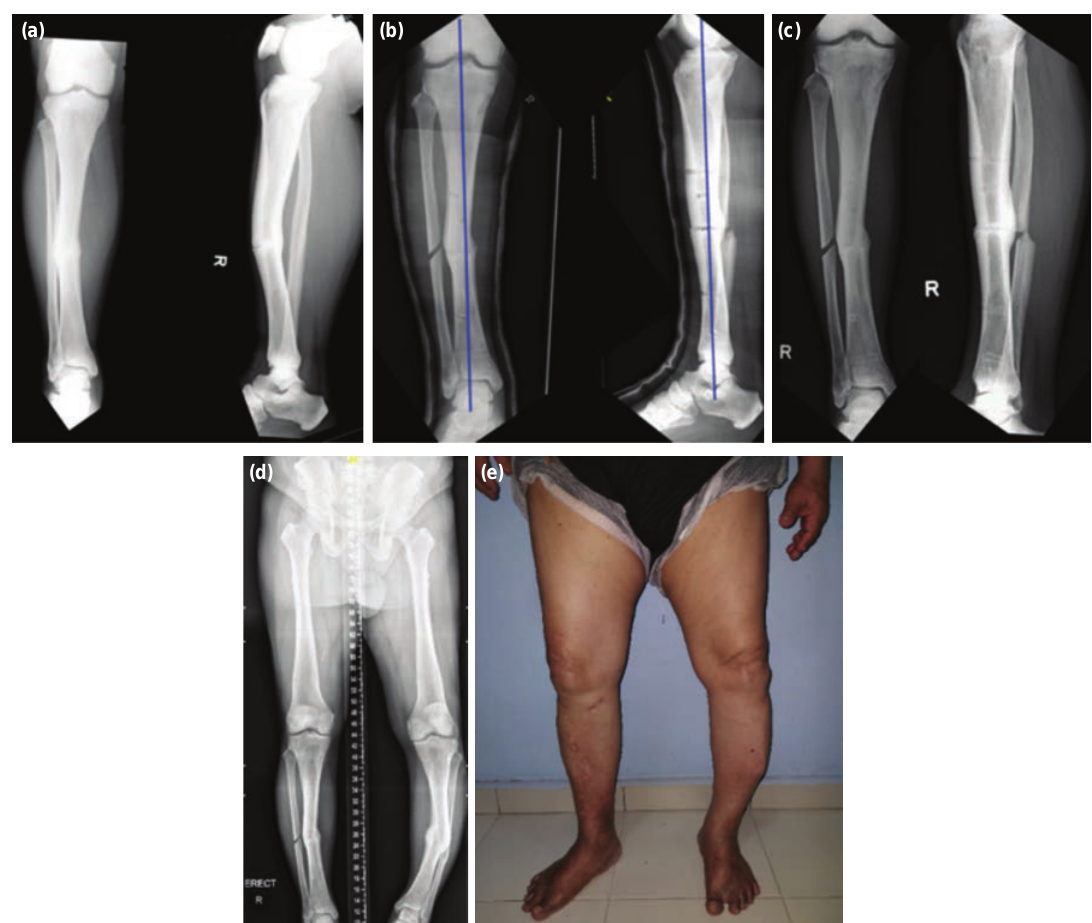
Post-operative radiographs. (a) and (b) Comparison pre-operative (a) and post-operative (b) radiographs. The post-operative Fig. 3: radiographs in (b) show complete bony union and correction of the procurvatum and varus deformities are demonstrated by the blue lines indicating the correction of the mechanical axis. (c) AP and lateral radiographs two years after index operation, showing solid union at the non-union site as well as correction of the varus and procurvatum deformities. (d) Long leg film showing the deformity correction at the right lower limb. (e) Clinical photo of the patient’s lower limb with the operated right lower limb demonstrating a comparatively normal mechanical